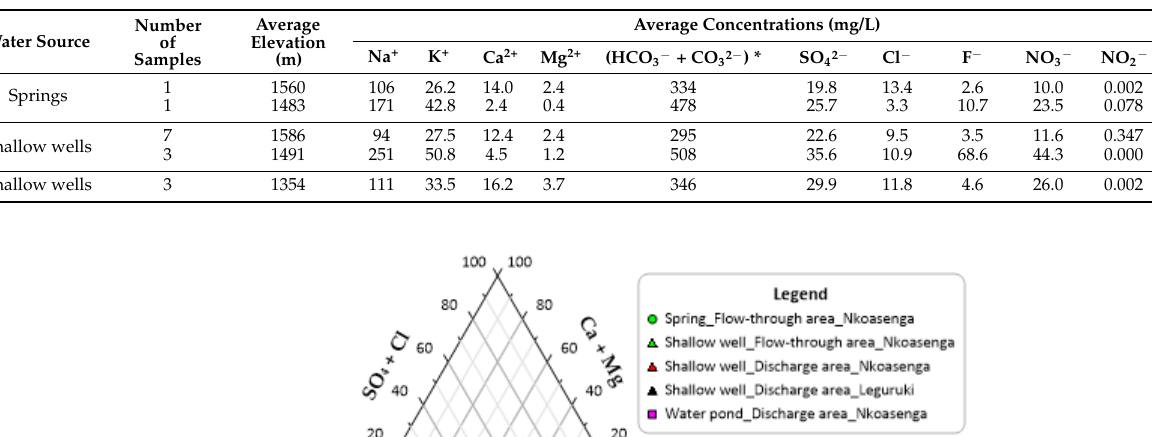
Table 5. Average values of major and minor ions in the water samples from different elevations on the northern flank of Ngurdoto crater (* as mg/L HCO 3 ⁻ ).